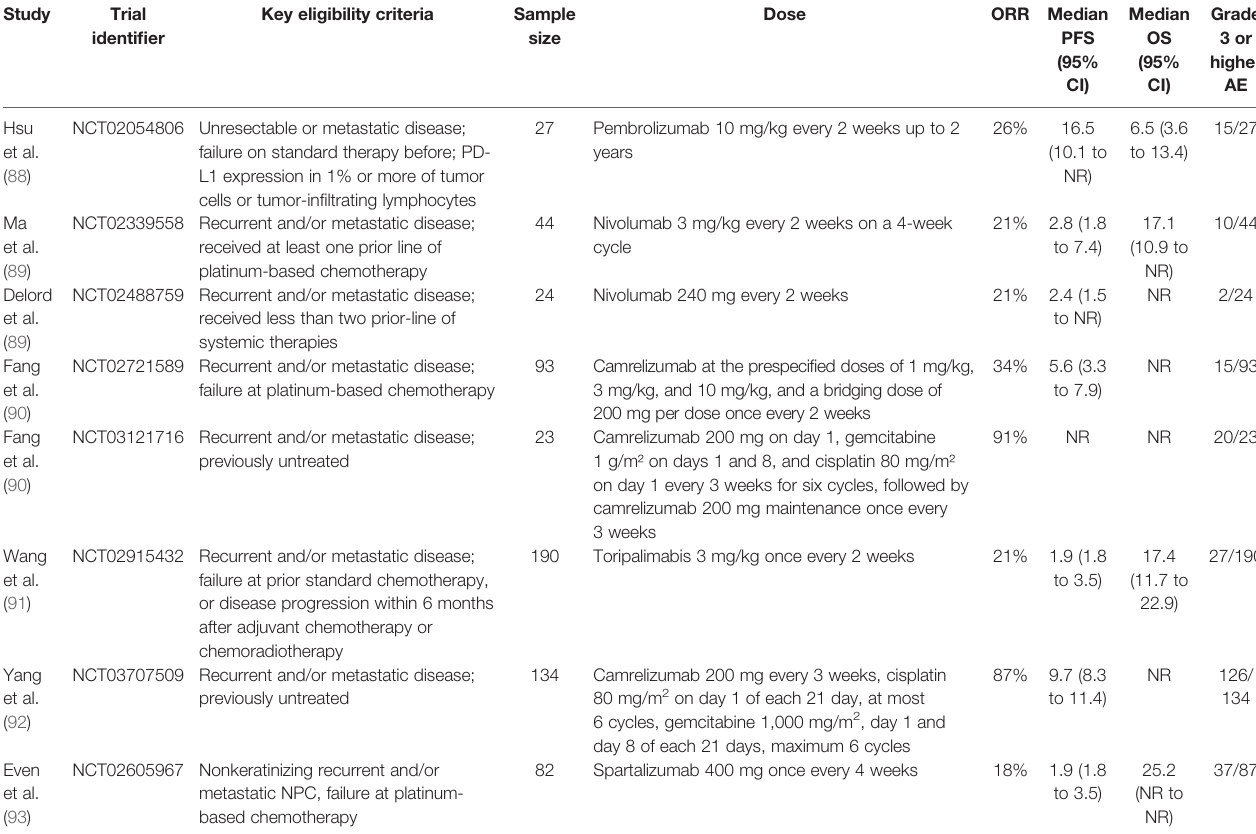
TABLE 2 | Completed clinical trials evaluating PD-1 inhibitors in recurrent and/or metastatic nasopharyngeal